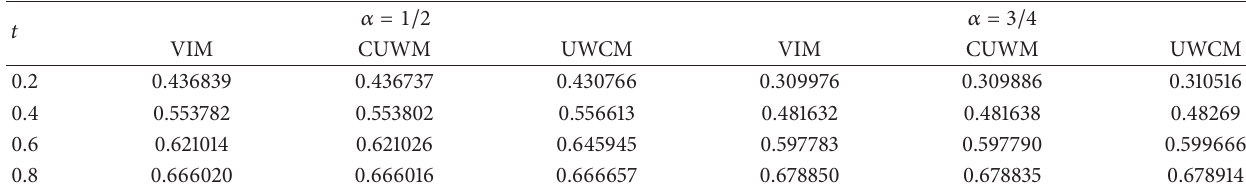
Table 4: Comparison between UWCM, VIM, and CUWM for Example 9 for 𝛼 = 1/2, 3/4